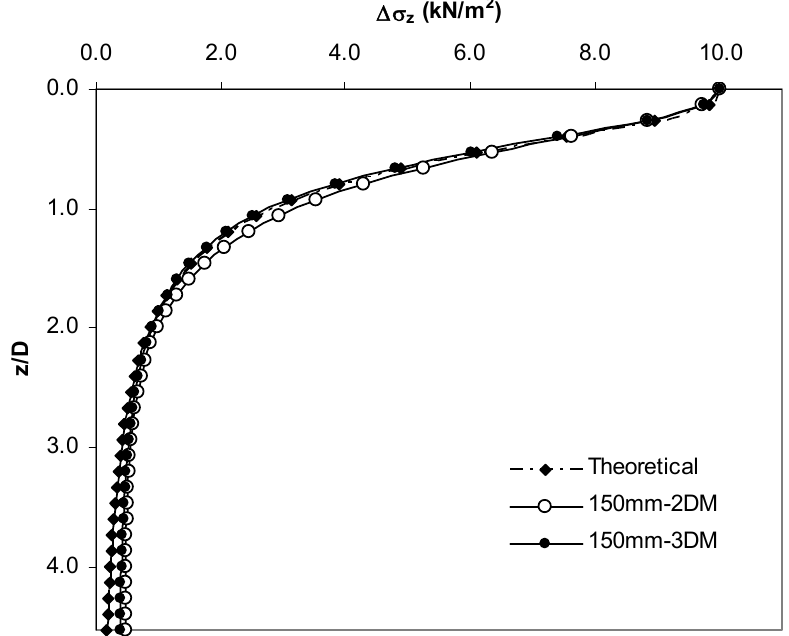
Figure 21. Vertical stress distribution (D = 150 mm).